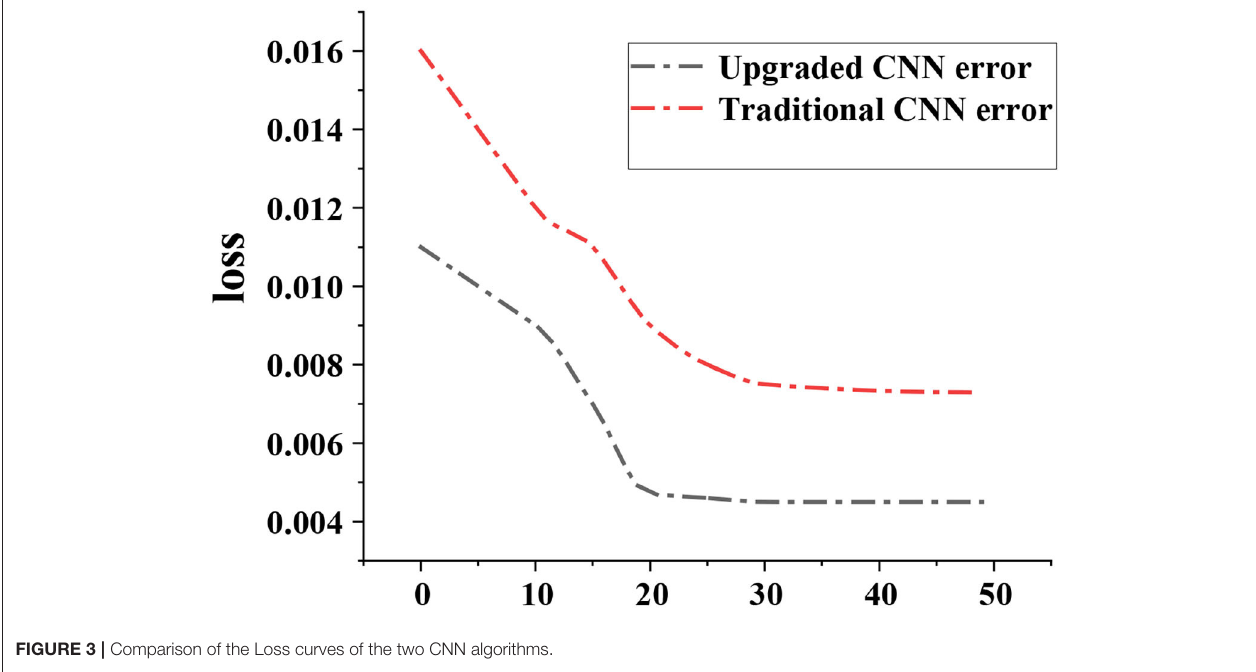
FIGURE 3 | Comparison of the Loss curves of the two CNN algorithms.